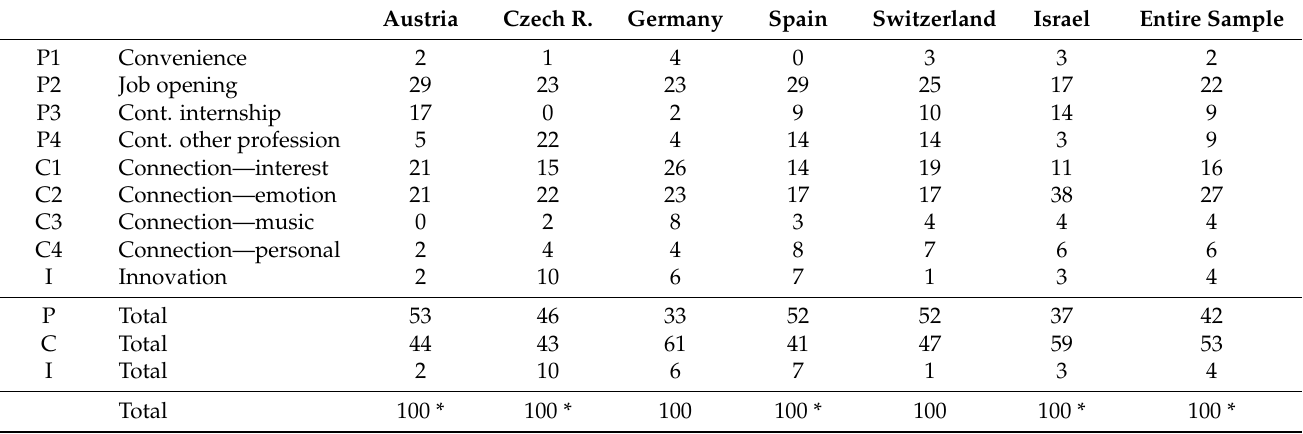
Table 2. Percentage of times that different reasons for working with clientele were mentioned: categories, subcategories in entire sample and according to